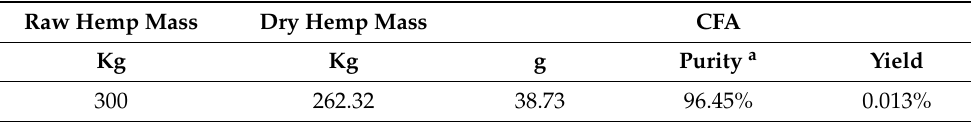
Table 1. Preparation of CFA from hemp aerial material at a gram-scale.